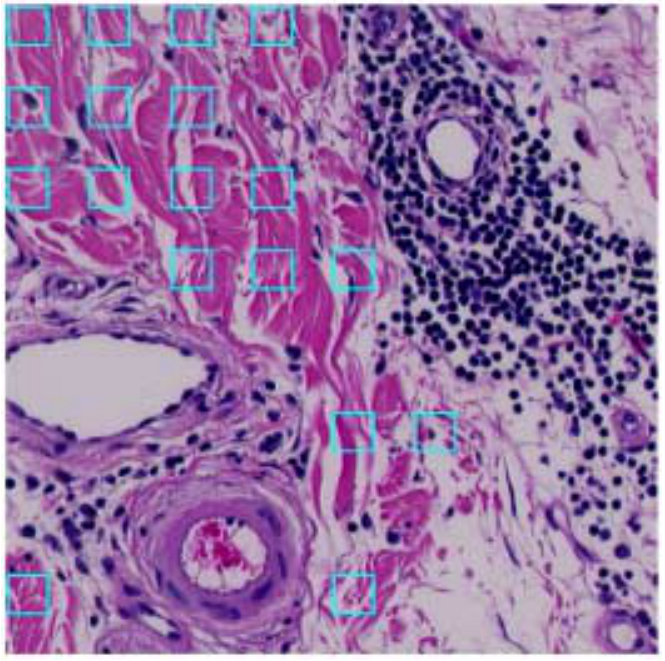
Fig. 2. Tissue counter analysis based on CART evaluation. Elements classified as connective tissue of the reticular dermis are indicated as squares. Loose adventitial connective tissue, cell-rich areas and inflammatory infiltrates as well as vessel walls are automatically